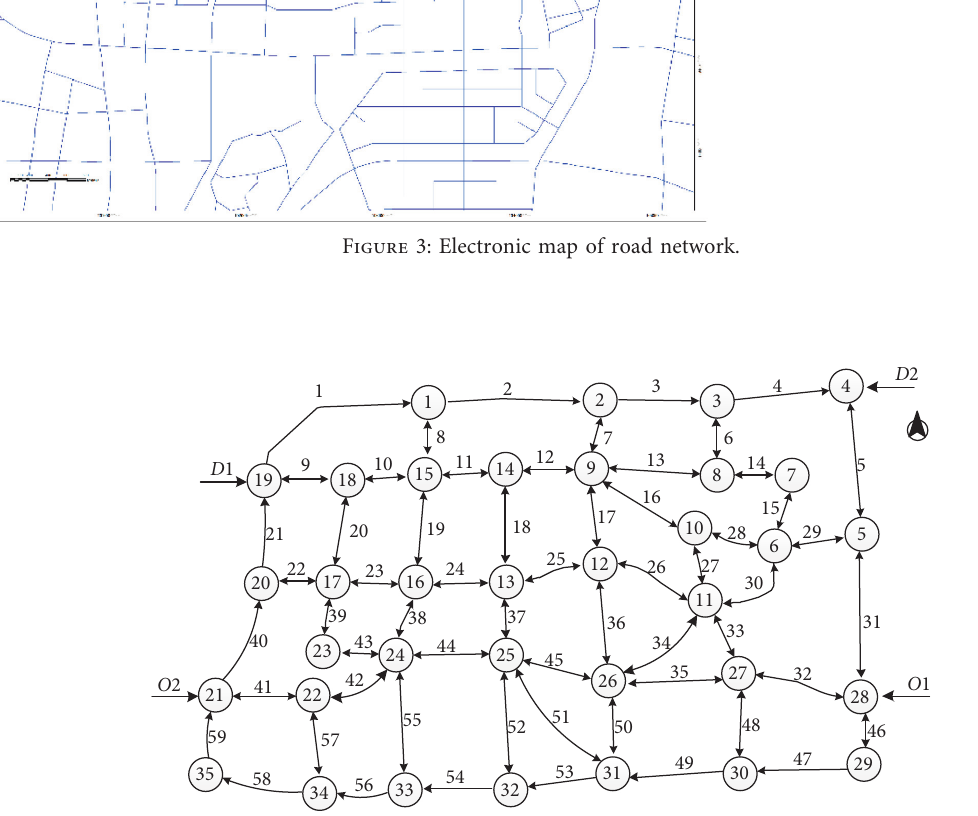
Figure 4: Backbone road network